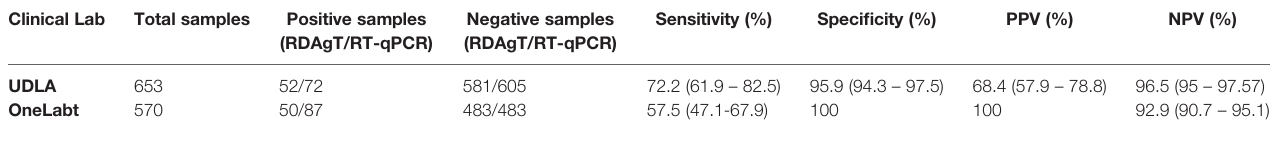
TABLE 5 | Independent evaluation of the clinical performance of the SARS-CoV-2 Rapid Diagnosis Antigen Test (RDAgT) from Certest Biotec at two different laboratories in Ecuador (total samples: number of samples included in the evaluation; positive samples: number of SAS-CoV-2 positive samples included in the evaluation for RDAgTs or RT-qPCR; negative samples: number of SARS-CoV-2 negative samples included in the evaluation for RDAgTs or RT-qPCR; PPV, positive predictive value; NPV, negative predictive value; parentesis includes